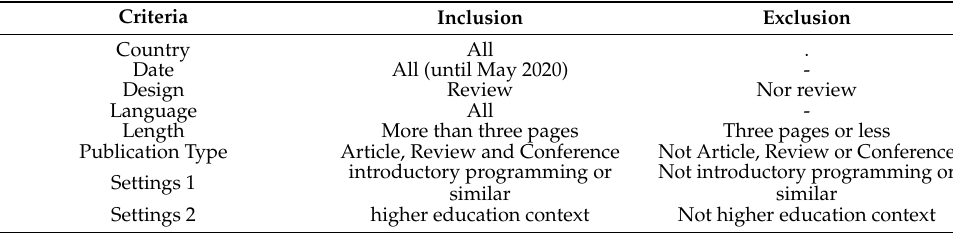
Table 2. Eligibility